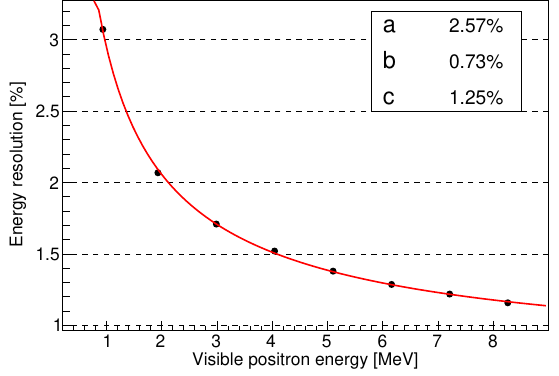
Figure 9 . A typical Gaussian fit to obtain the energy resolution σ /mean for 3 MeV positrons, with reconstructed by eq. (3.3). E prompt vis